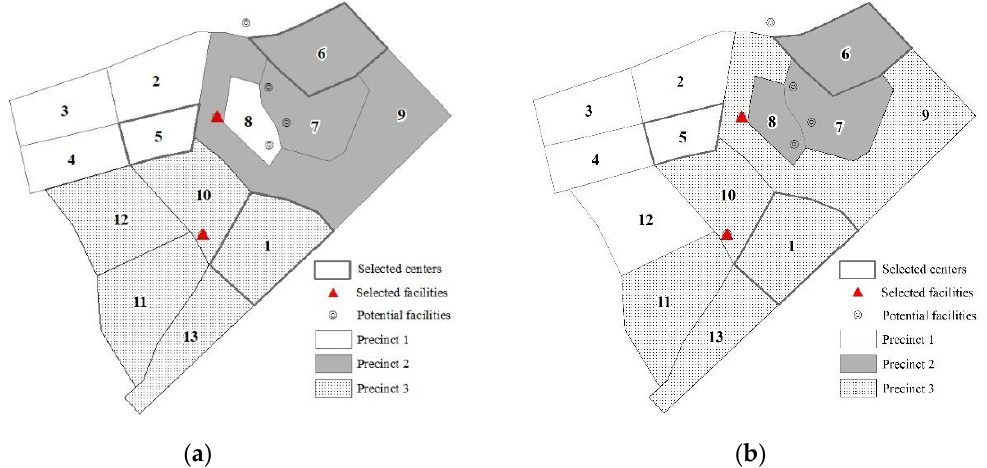
Figure 3. Role of the contiguity constraints in the CDPMP-P: ( a ) without contiguity constraints; ( b ) with contiguity constraints.